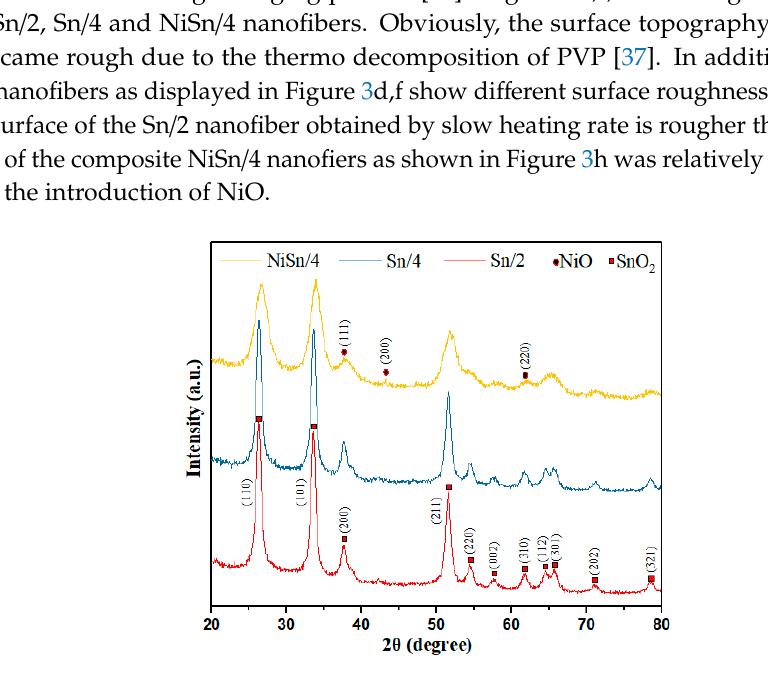
Figure 2. X-ray di ff raction (XRD) spectra of Sn / 2, Sn / 4 and NiSn / 4 nanofibers. Figure 2. X-ray diffraction ( XRD) spectra of Sn/2, Sn/4 and NiSn/4 nanofibers.